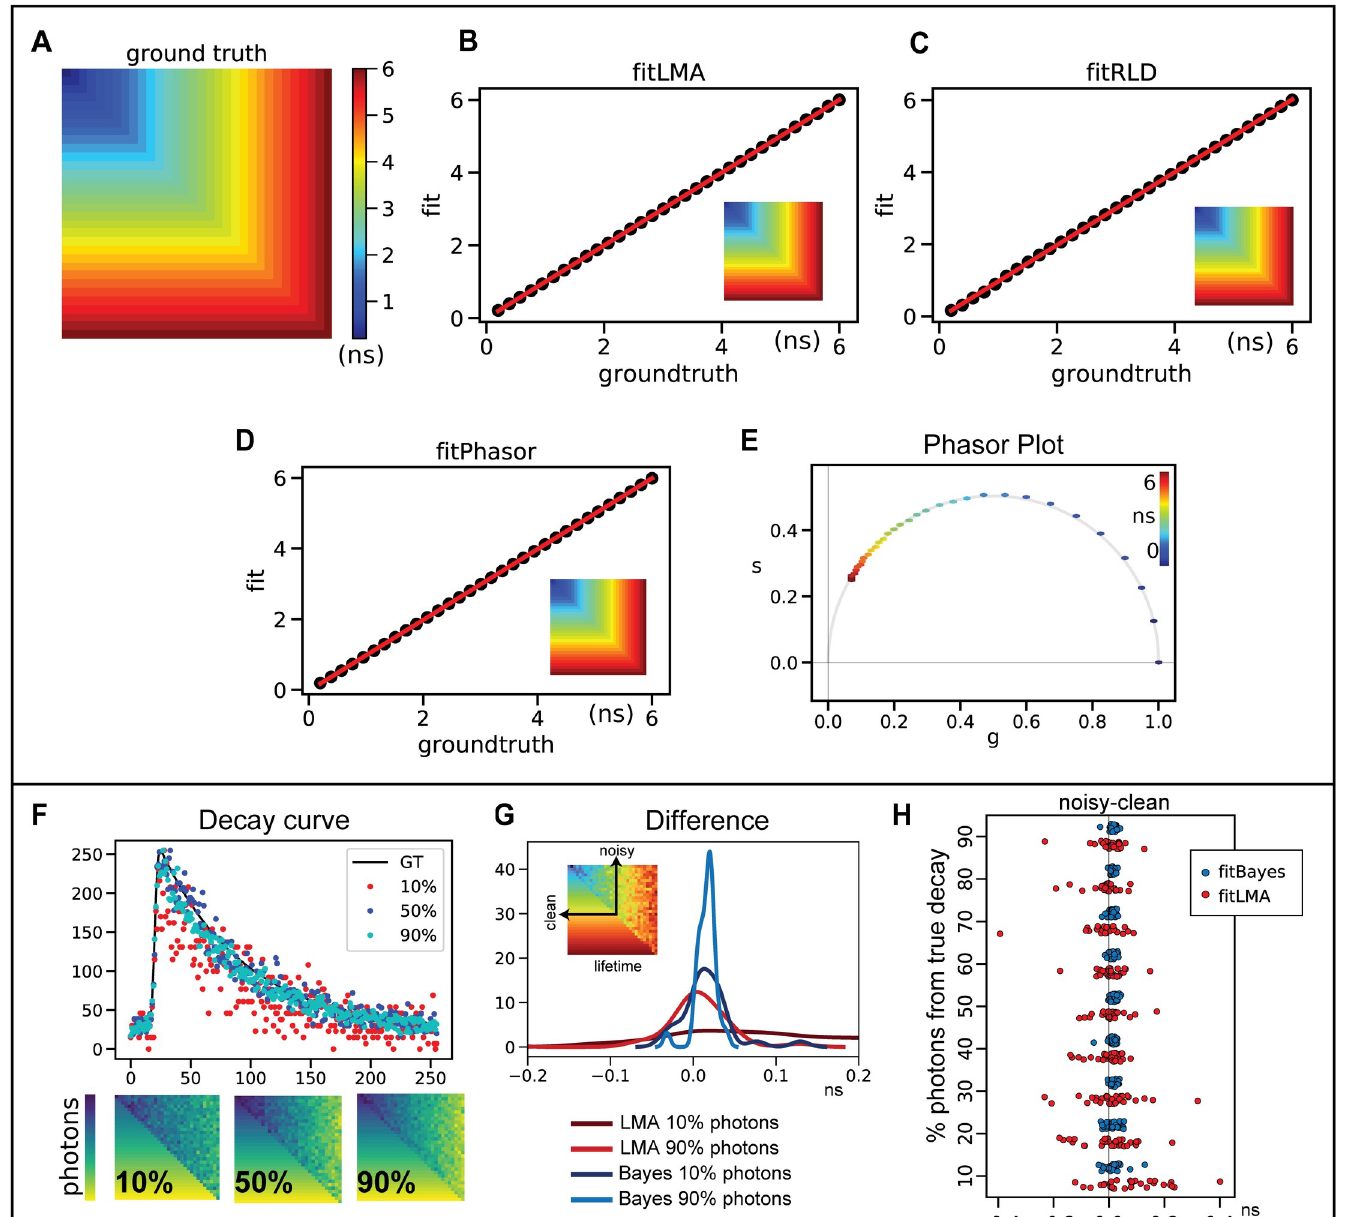
Fig 5. FLIM Validation using a simulated dataset for 1-component fitting. The lifetime values range from 0.2 ns to 6.0 ns that fit within the fitting range of 10 ns. A) Ground truth lifetime distribution. B) Ground truth is compared against lifetime estimates obtained using B) LMA, C) RLD, and D) Phasor. The insets in panels B-D shows the maps of lifetime estimates generated by each method. E) The phasor plot for the estimates shown in panel D. Panels F-H) shows how Bayesian fits generate a better accuracy in low-photon decay curves. F) The ground truth data was trimmed down to a fraction of total photons (10% - 90%). The data is divided diagonally half as noisy and clean. Three representative images of 10%, 50%, and 90% of total photons are compared for total photons and a sample decay curve at 4ns. A different color-map is used here to highlight that this is the photon counts and not the lifetime map. G, H) The differences between fit results of the noisy (10% - 90% photons) and clean decay curves of a range of lifetime values (0.2–6.0 ns) are presented in panel H. The LMA distribution shows a larger variance at lower photons in comparison to Bayes. Bayes fit gives a better representation to the clean curve than LMA with as low as 10% total photons. Panel G compares two representative distribution of photons: 10% and 90% for both Bayes and LMA. Bayes converges approximately four times better than LMA. The inset in panel G shows how the values are extracted for 32-lifetime value.